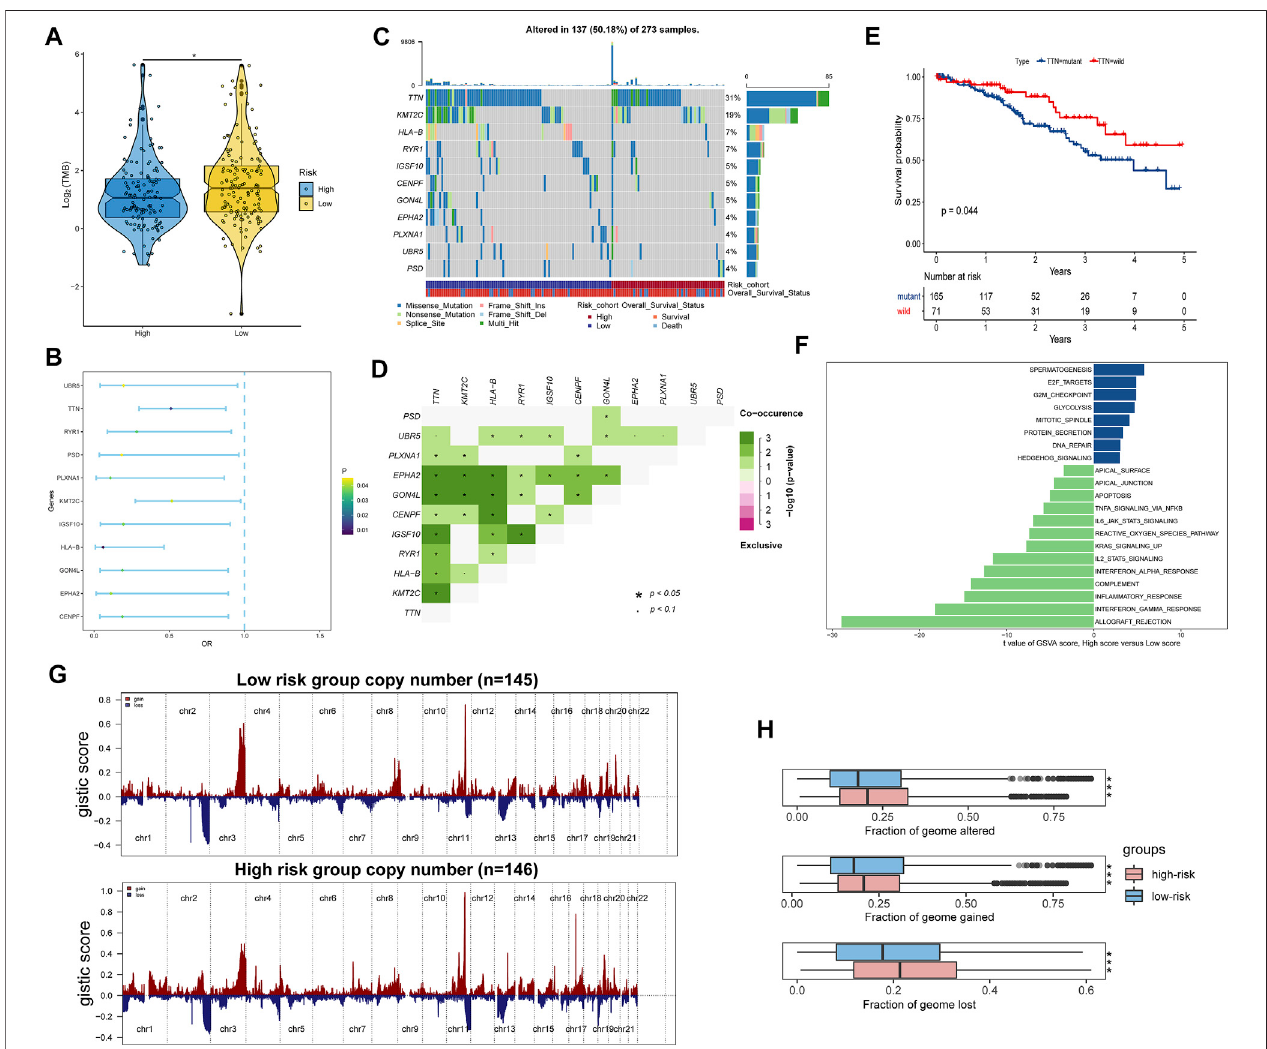
FIGURE 7 | Identi fi cation differences of the genetic variation and pathway activation between high- and low-risk groups. (A) Tumor mutation burdens were comparedamongdistinctriskgroups. (B) Forestplotofgeneswithdifferencesinmutationfrequenciesbetweenthelow-andhigh-riskgroups. (C) Waterfallplotofthe11 mutant genes with signi fi cant frequency differences between low- and high-risk groups. (D) Interaction of differentially mutated genes. (E) Kaplan – Meier curve showing that patients with mutant TTN have a better OS than those with wild type. (F) Differential analysis of GSVA scores among distinct risk groups. (G) Copy number alteration gains(red) and losses(blue)between thelow- and high-riskgroups. (H) Differentialanalysisofaltered,lost,and gainedgenomefractions (%)betweenthelow- risk and high-risk groups. * p < 0.05; ** p < 0.01; *** p < 0.001; ns, not signi fi cant.